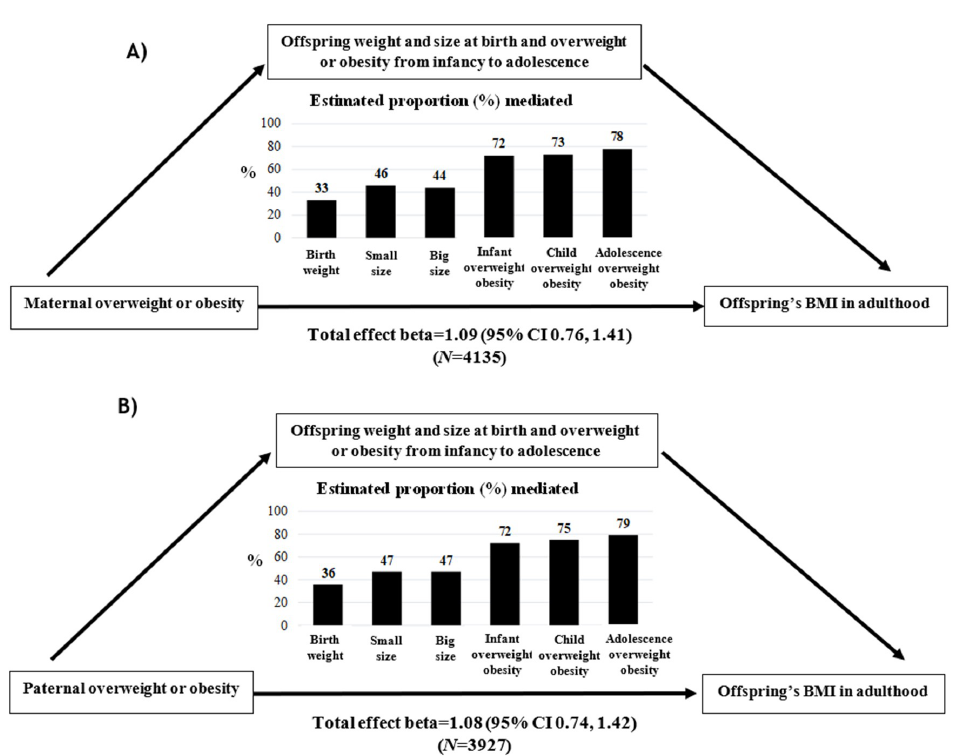
Figure 3. Estimated mediated proportion effect of ( A ) maternal and ( B ) paternal overweight–obesity grade on the offspring’s BMI in adulthood via birth weight, size at birth, and overweight–obesity grade from infancy to adolescence in the ONTIME